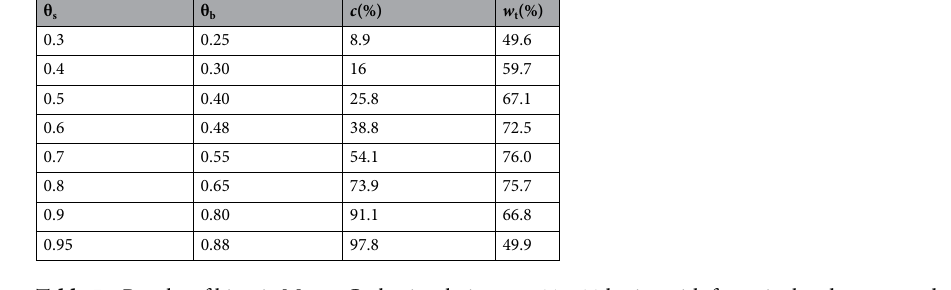
Table 5. Results of kinetic Monte Carlo simulations on 11 × 11 lattice with four-cite border averaged over 10 6 runs; θ s is the substrate coverage, θ b is the averaged coverage of the border, c is the percentage of border configurations with two or more A or B, w t is the total duration of the working periods expressed as percentage of the run